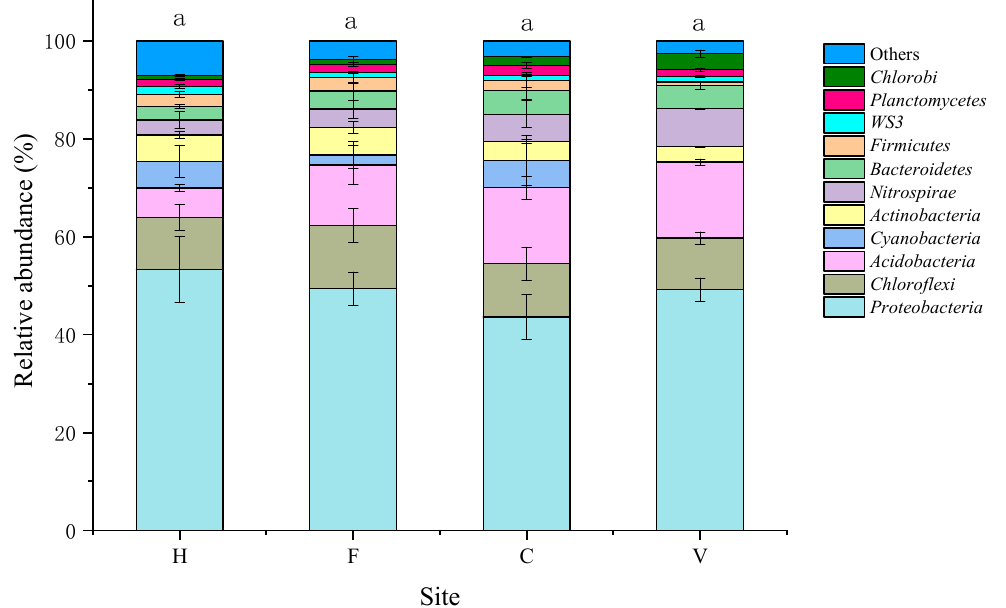
Figure 7. The abundance of dominant bacteria at the phylum level. H: hospital; F: farm; C: city residence; V: village residence. Error bars indicate standard errors of three replicates, different lowercase letters indicate a significant difference ( p < 0.05).